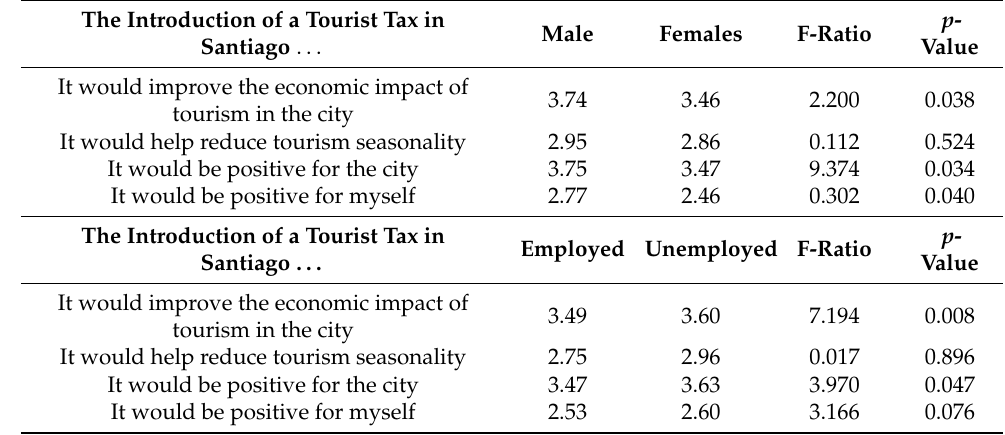
Table 8. Perception of the implementation of the tourist tax according to gender and employment